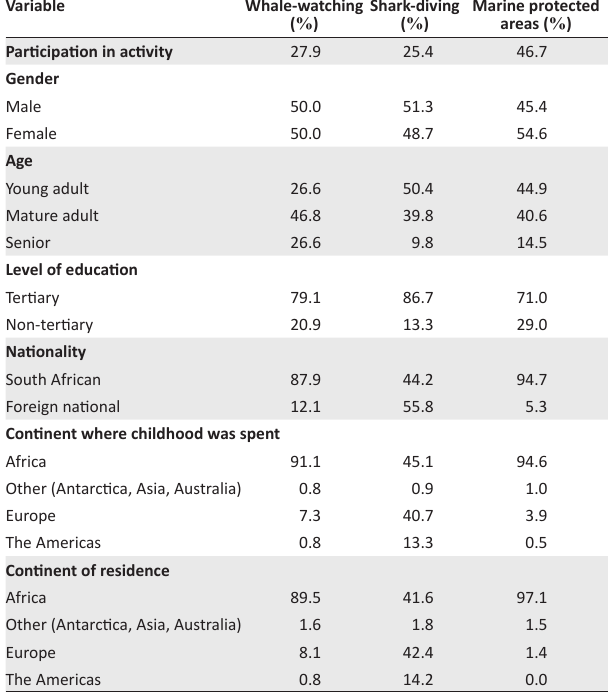
TABLE 1: Cross-tabulation of sample’s demographic profiles among activities.